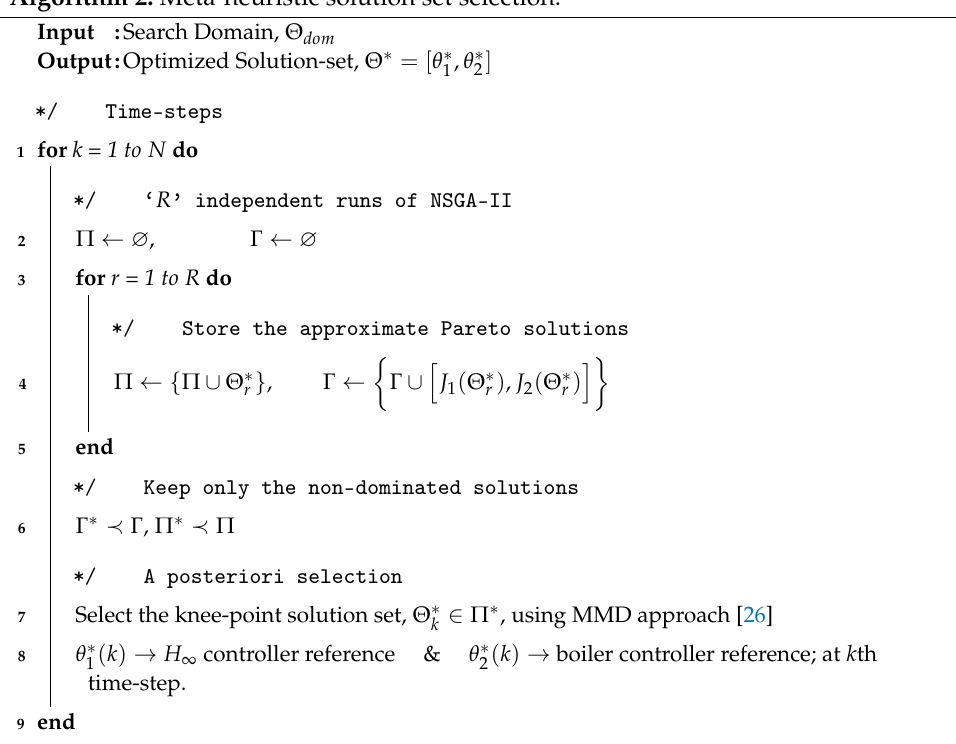
Algorithm 2: Meta-heuristic solution set